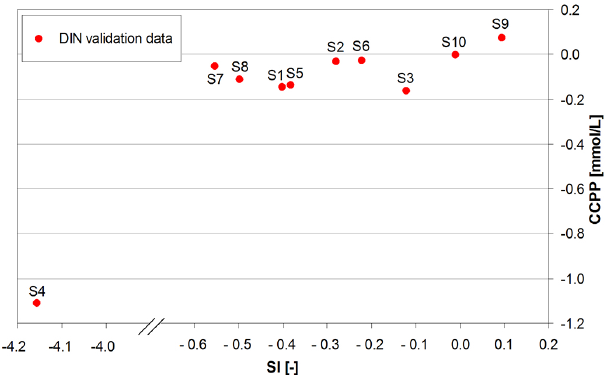
Figure 6. CCPP values plotted against the SI (data from the DIN validation data set, see Table